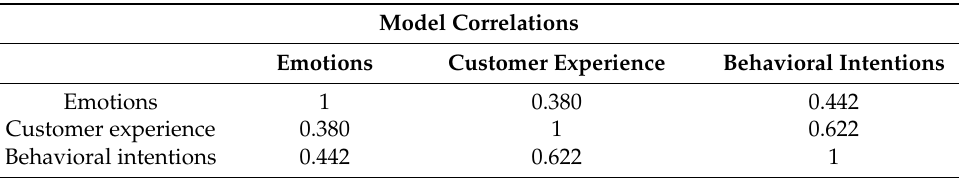
Table 4. Correlations (emotions, customer experience, behavioral intentions).